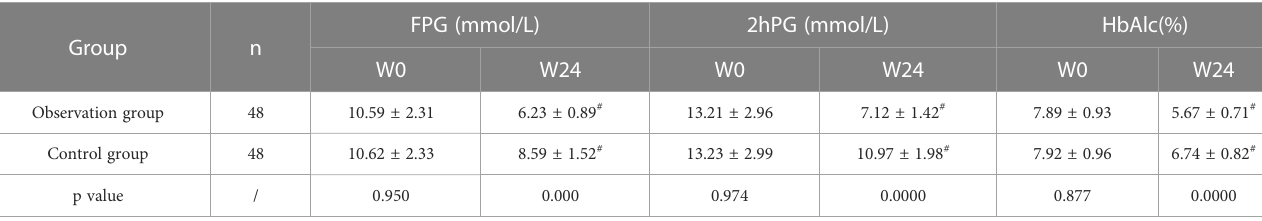
TABLE 1 Comparison of glucose metabolism indices between control and observation groups.